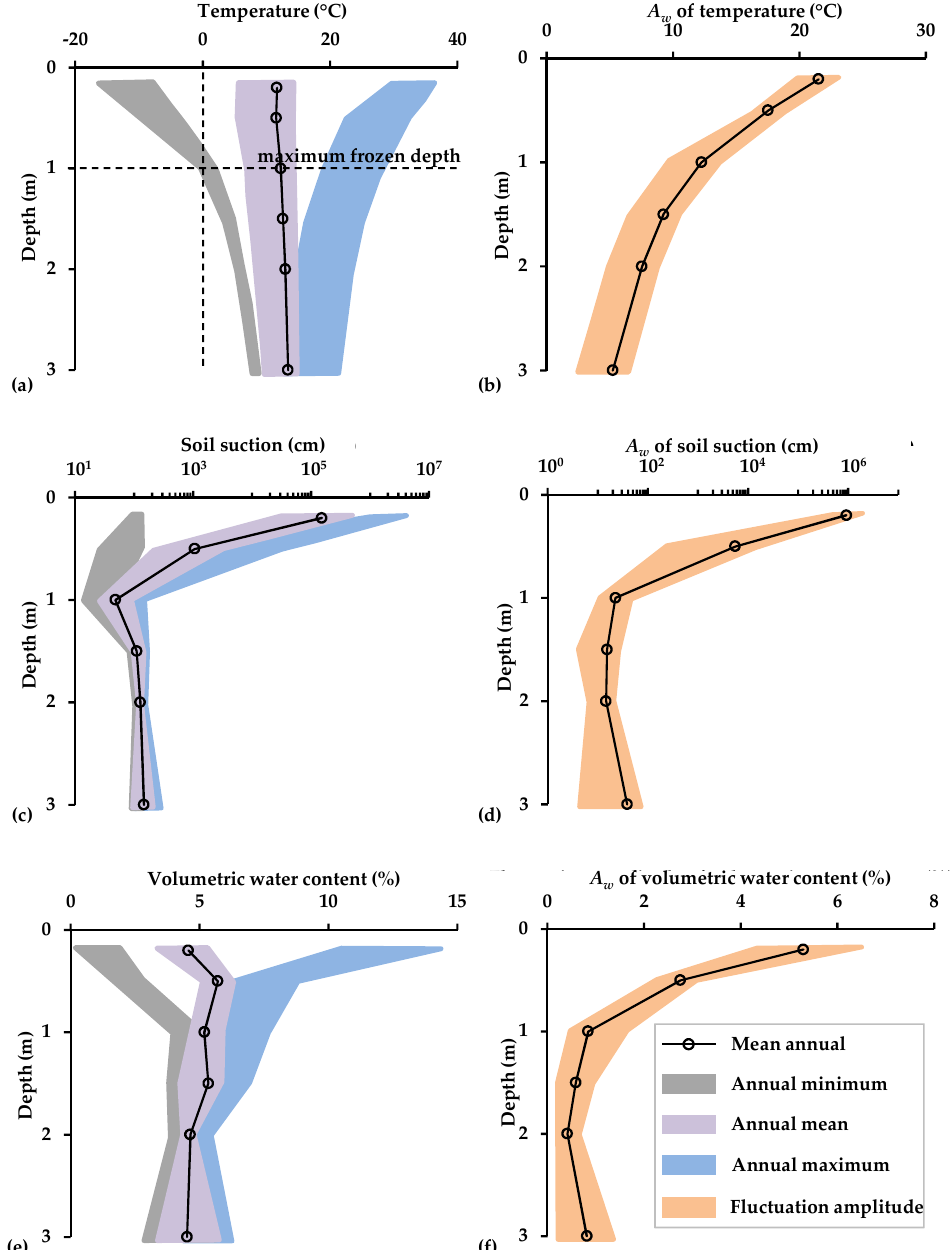
Figure 4. Depth-dependent indices in the shallow vadose zone: ( a ) Temperature; ( b ) fluctuation amplitude of temperature; ( c ) soil suction; ( d ) fluctuation amplitude of soil suction; ( e ) volumetric water content; and ( f ) fluctuation amplitude of volumetric water content.